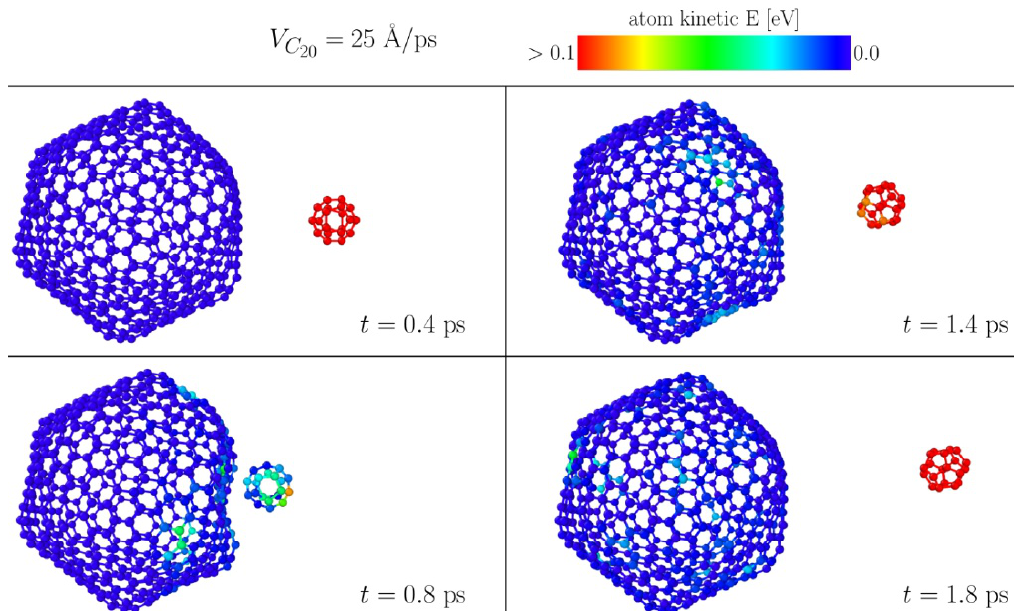
Fig. 2. Snapshots of the fullerene collision at the initial velocity V fullerenes colliding at a velocity within the range V kinetic energy